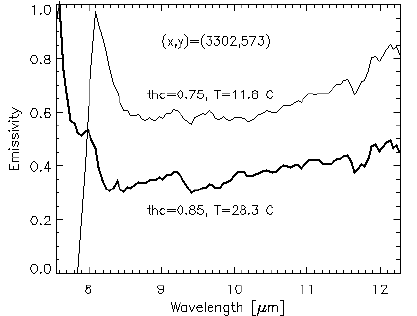
Figure 7. Sample of cold pixel emissivity and corrected emissivity spectrum. Figure 8. Scene with horizontal data acquisition. Top: spectral radiance, RGB= 10.9, 9.0, 8.1 µm , 2nd: spectral emissivity (RGB, same wavelengths), 3rd: temperature (scaled 30 − 60 o C ) bottom: inverse spectral angle mapping with R:Goethite, G:Kaolinite,